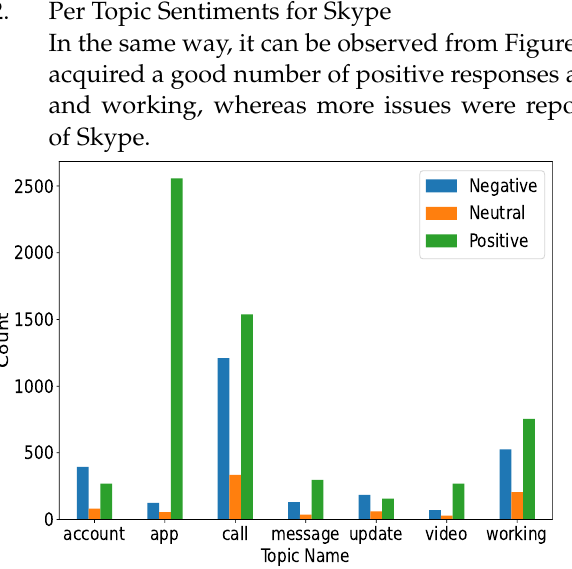
Figure 10. Sentiments related to Skype.